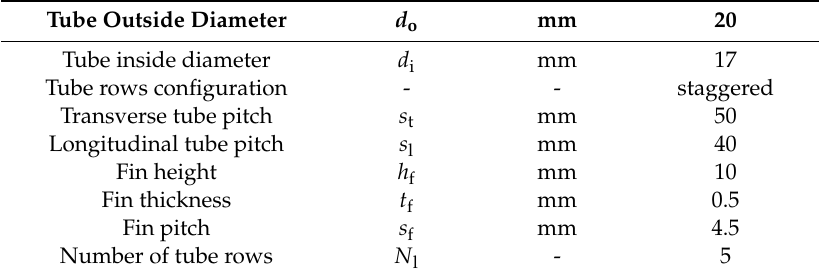
Table 2. Characteristic dimensions of tube and fins.